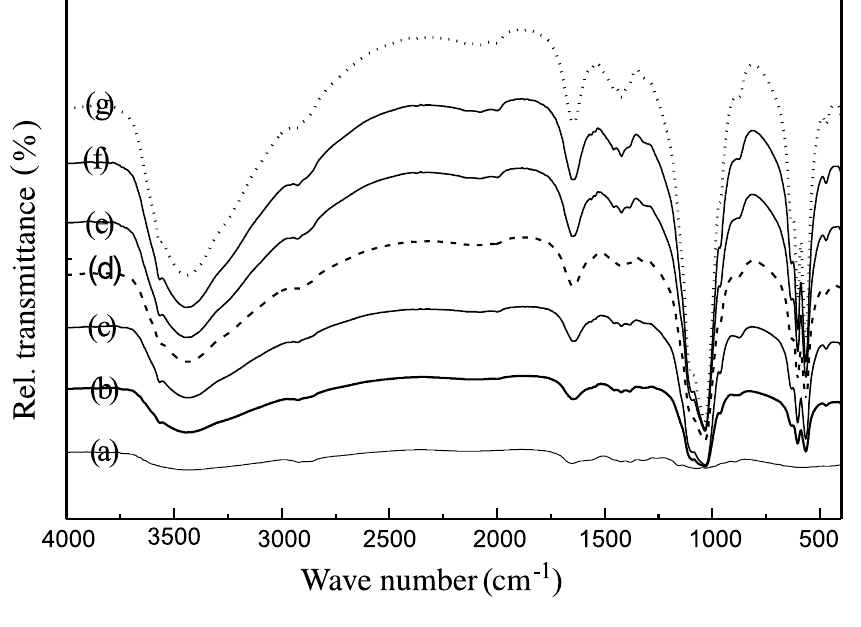
Fig. 1 – FTIR spectra from: (a) Chitosan, (b) HAp100, (c) HApIII, (d) composite I, (e) composite III, (f) composite V, and (g) composite VI.